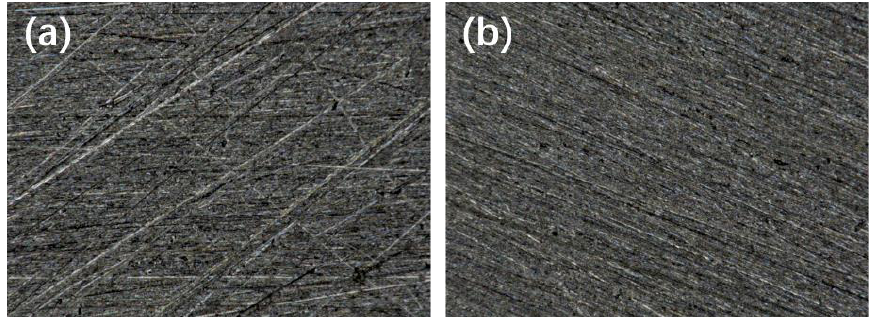
Figure 1. ( a ) Q235 steel sanded with 500# sandpaper and ( b ) Q235 steel activated with hydrofluoric acid for 1 min.